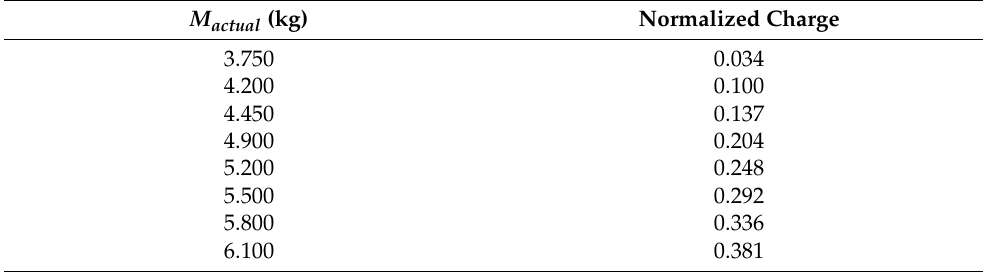
Table 2. The actual charge and corresponding normalized charge.